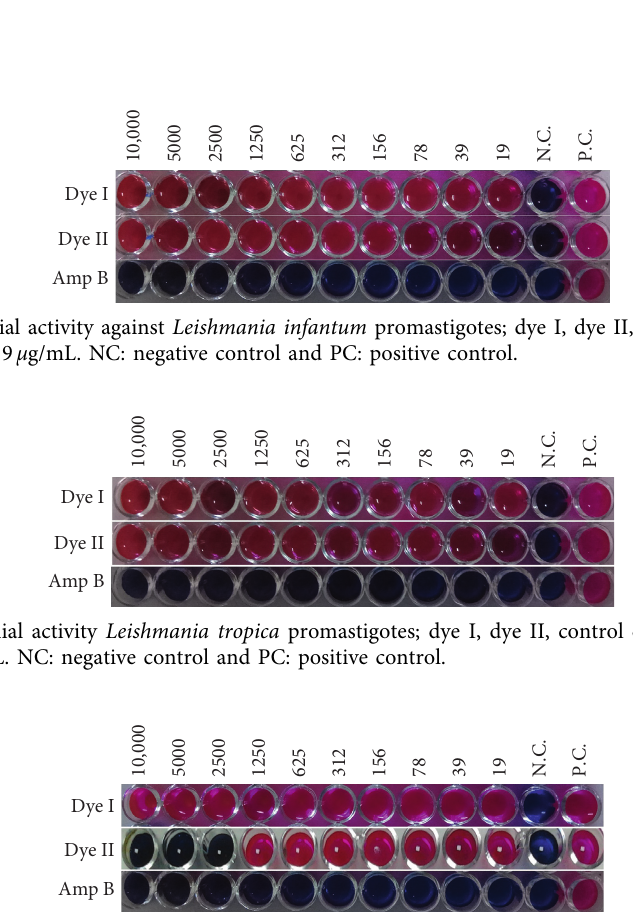
Figure 6: In vitro antileishmanial activity Leishmania major promastigotes; dye I, dye II, control drug amphotericin B, and dilution concentrations 10,000–19 μ g/mL. NC: negative control and PC: positive control. Table 4: Minimum inhibitory concentration (MIC) values (in μ g/mL) obtained against standard Leishmania promastigotes. Dyes